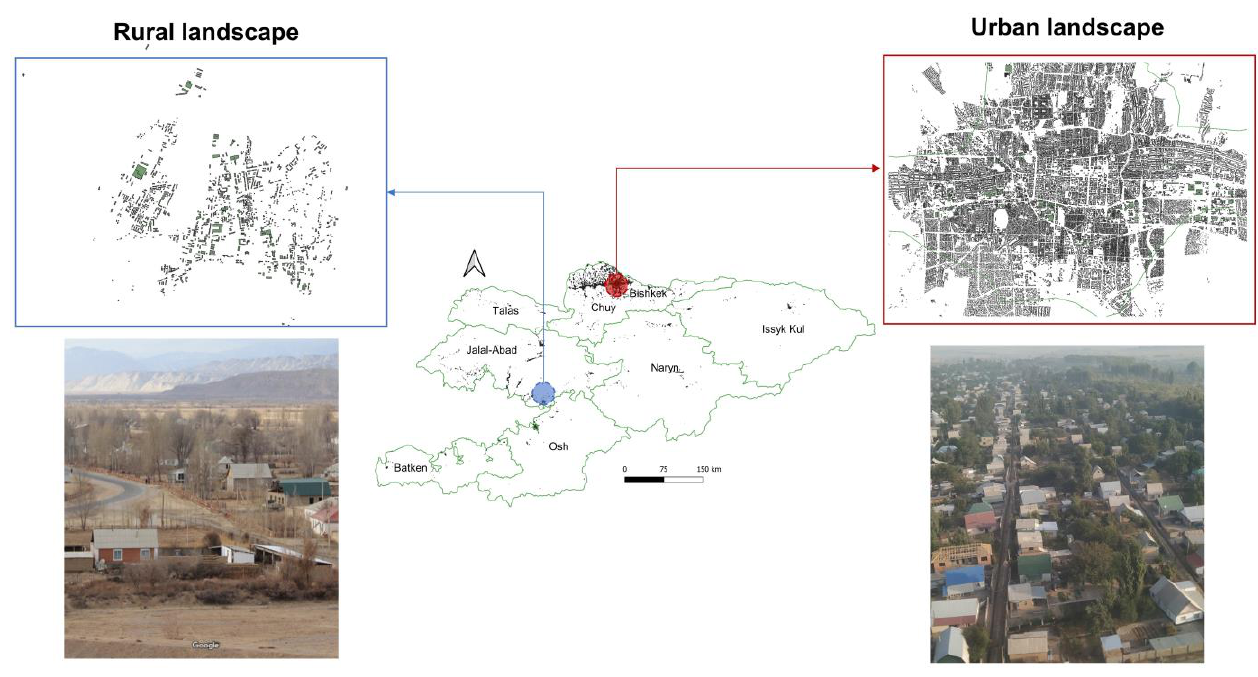
Figure 2. Exemplary building footprints of rural and urban settlement of Kyrgyzstan (Own illustration based on GIS data according to Humanitarian OpenStreetMap Team).